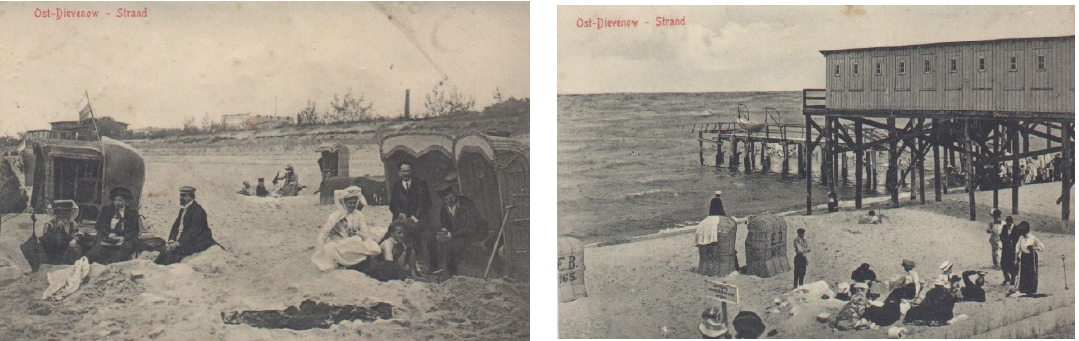
Figure 3. The beach in Dziwnow—the postcards. Source: Author’s private collection.